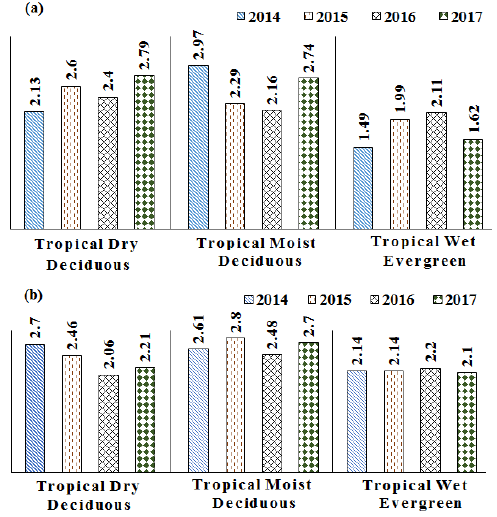
Figure 8. Illustration of pattern difference using (a) SIF & (b) NDVI